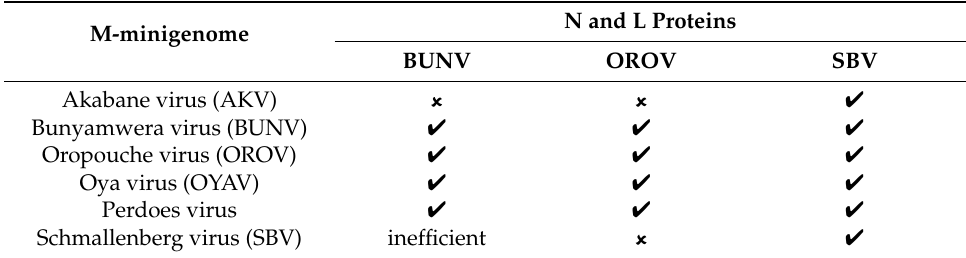
Figure 11. Polypseudorotaxanes inter- or intra-crosslink with each other via hydrogen bonding. Table 2. Ten percent 10KPEGMA and 10% P-10K solutions with 10% α -CD. Table 1. A summary of the medium segment based minigenomes (M-minigenome) that are functional with either the N and L proteins of BUNV, OROV or SBV ( indicates that Renilla activity was not detected, (cid:52) indicates that Renilla activity was detected).